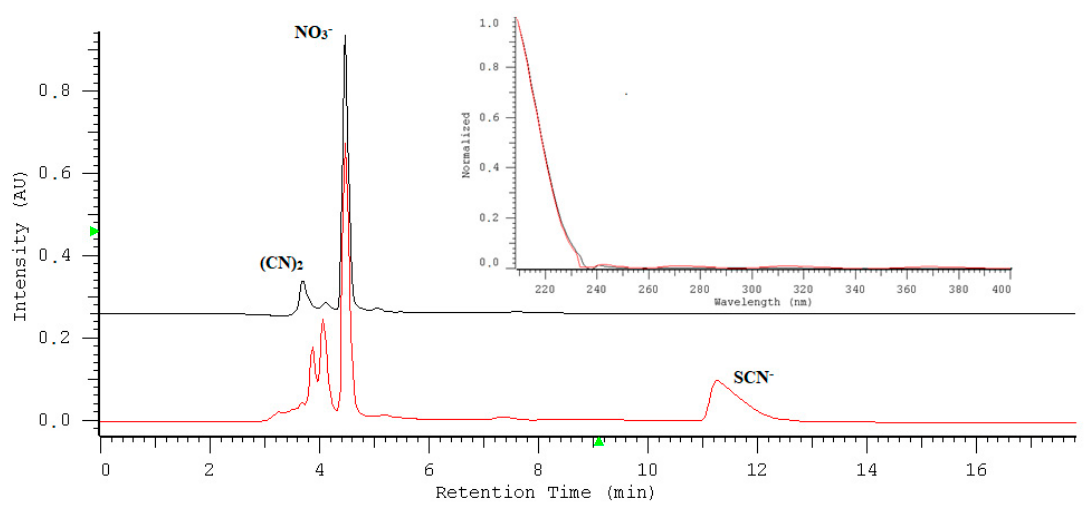
Figure 7. The overlapped chromatograms; the red line represents the separation of the saliva sample before oxidation, and the black line that after oxidation. Insert: UV-absorption spectra of nitrate in water (the back line) and in the saliva sample (the red line) recorded in the range of 190 to 400 nm. Table 4. Nitrate/nitrite levels in saliva samples ( n = 6).